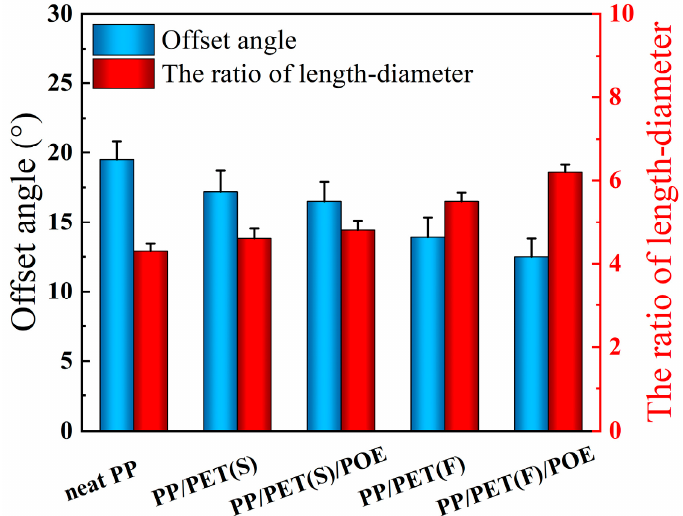
( b ) PP/PET(S), ( c ) PP/PET(S)/POE, ( d ) PP/PET(F), ( e ) PP/PET(F)/POE. PP/PET(S), ( c ) PP/PET(S)/POE, ( d ) PP/PET(F), ( e ) PP/PET(F)/POE.